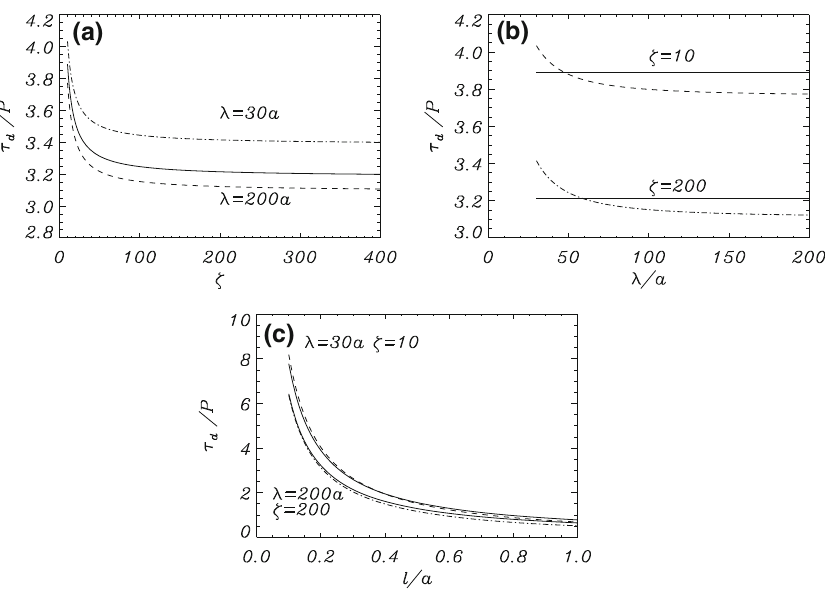
Fig. 68 Wave damping by Alfvén resonant absorption in an infinitely long prominence thread. Damping time over period for fast kink waves in filament threads with radius a = 100 km. a As a function of the density contrast, with l / a = 0 . 2 and for two wavelengths. b As a function of the wavelength, with l / a = 0 . 2, for two density contrasts. c As a function of the transverse inhomogeneity length-scale, for two combinations of wavelength and density contrast. In all plots solid lines correspond to analytical solutions given by Eq. (37), with F = 2 /π . Image reproduced with permission from Arregui et al. (2008b), copyright by